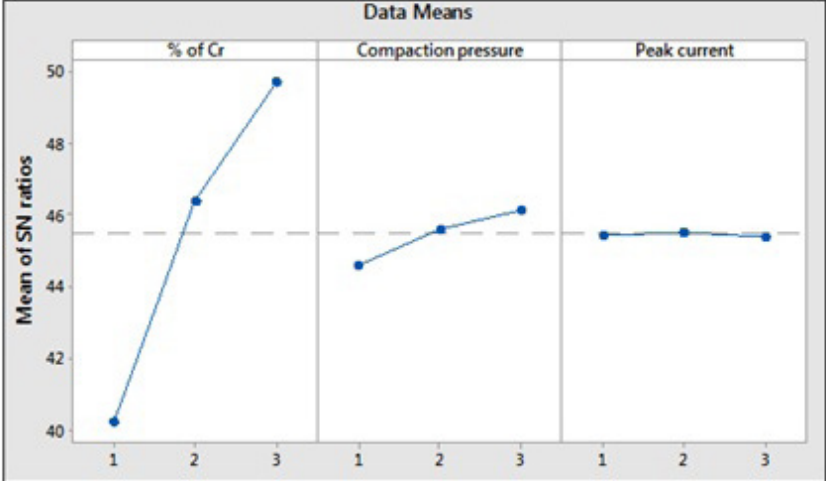
Figure 6. Desirable factor for